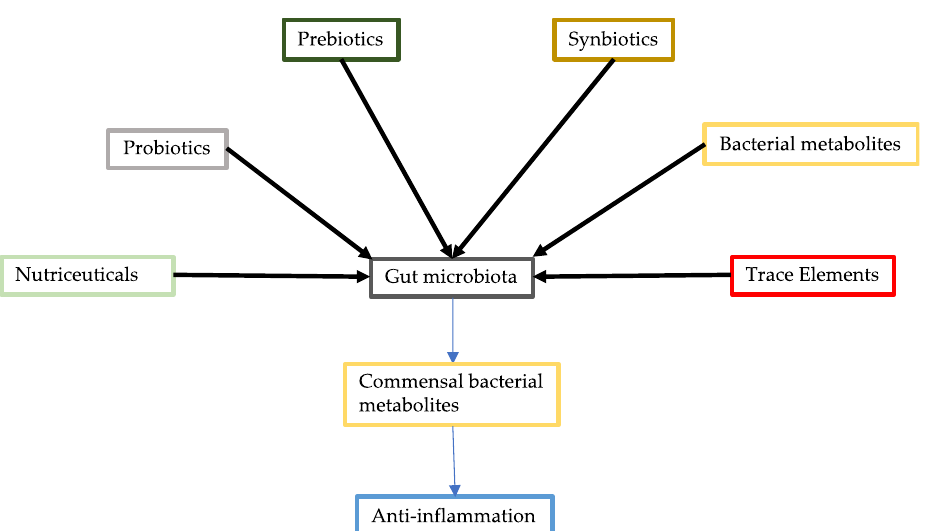
Figure 1. Modulation of gut microbiota. Gut microbiota can be improved through various approaches including administration of probiotics, prebiotics, synbiotics, commensal bacterial metabolites, nutraceuticals, and trace elements. Improved gut microbiota can increase production of commensal bacterial metabolites, which have an anti-inflammatory effect.